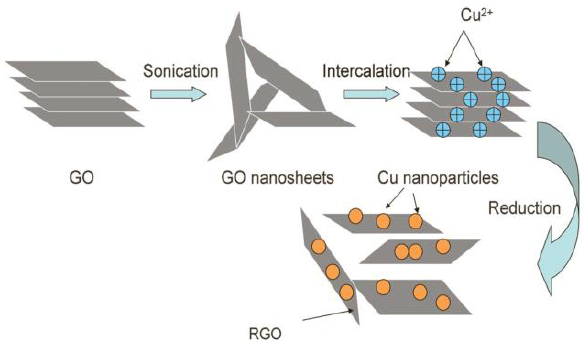
Figure 6. Preparation of RGO/Cu nanoparticle composites. Step 1: Graphene oxide (GO) nanosheets are exfoliated to lots of single GO nanosheets and the metal cations are inserted on single GO nanosheets.Step 2: Cu nanoparticles are generated on the action of strong reductant. Reproduced with permission from reference Zhang et al. [98], Copyright 2013, RSC Advances.